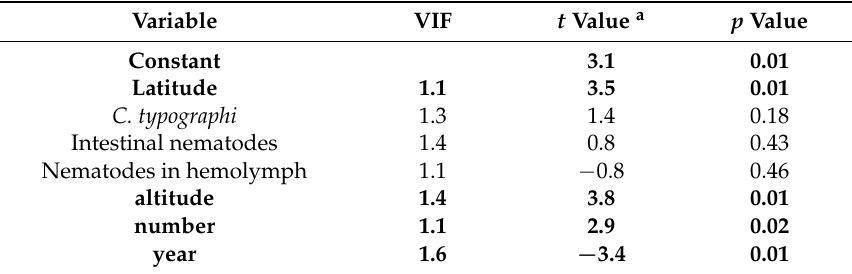
Table 4. Results for a regression model describing the relationship between the L. duplicati infection levels in I. duplicatus populations and the following variables: latitude (north-south gradient); infection level of C. typographi ; parasitism by intestinal nematodes; parasitism by hemolymph nematodes (i.e., nematodes detected in the hemolymph); altitude; number of I. duplicatus beetles captured and dissected; and year (date of beetle collection). Variance Inflation Factor (VIF), corrected Akaike’s Information Criterion (AICc) = − 11.93. Significant variables are in bold.